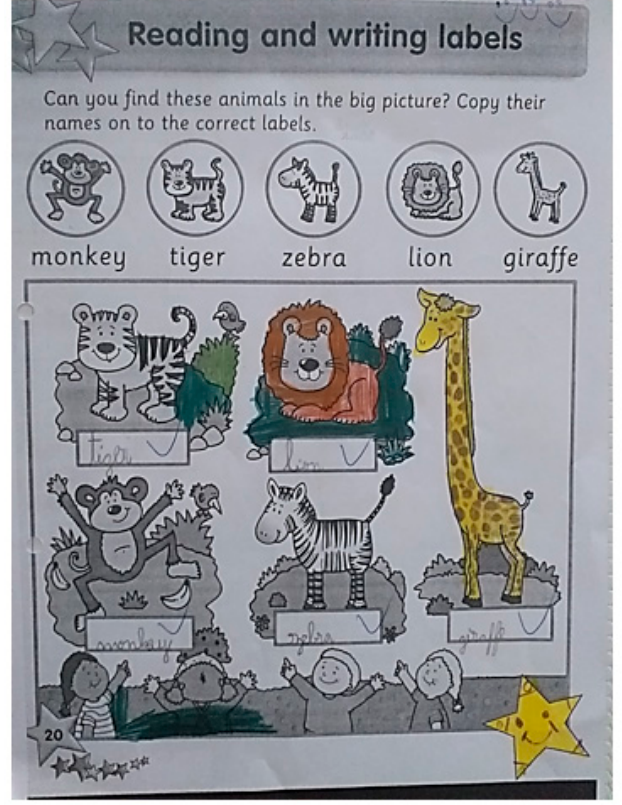
Figure 3. Children’s ability to read, recognize and correctly assign labels to pictures.